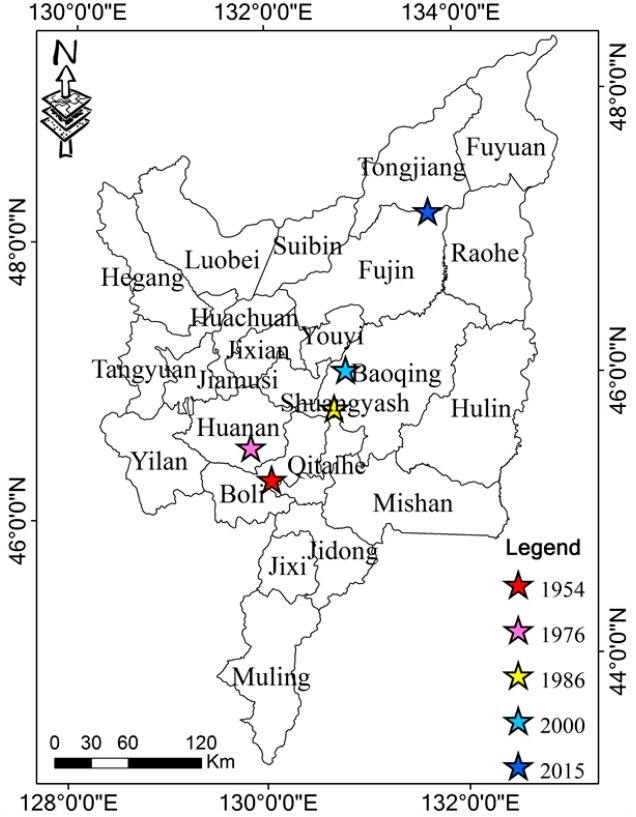
Figure 6. The gravity centers of paddy fields during different times.